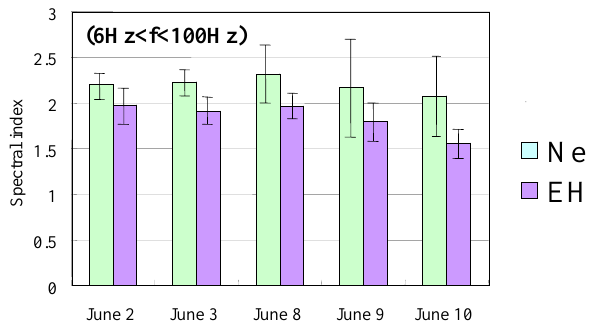
Fig. 3. Average spectral indices of the electron density (white) and electric field (shadowed) fluctuations inside the ESF for 5 different nights (20 ∼ 22 LT) for the frequency from 6Hz to 100Hz. Error bars indicate the relevant standard